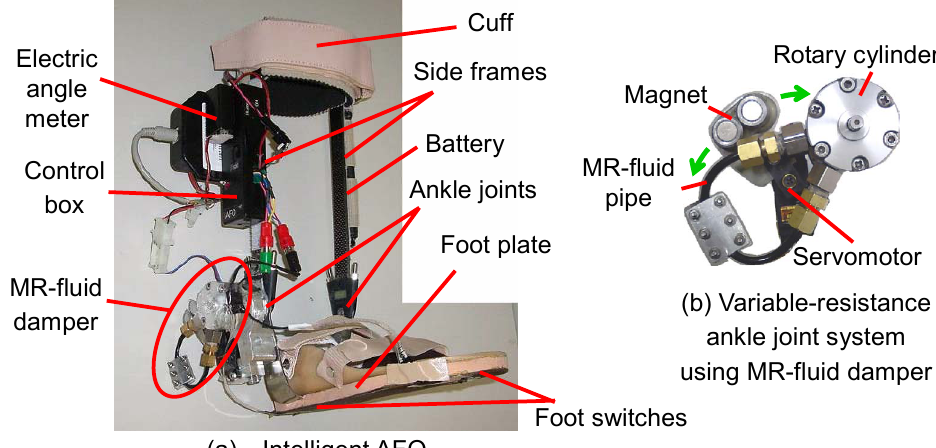
Fig. 1 The intelligent AFO (iAFO) is shown. The MR-fluid damper connected to the commercial ankle joint can vary the orthotic resistance